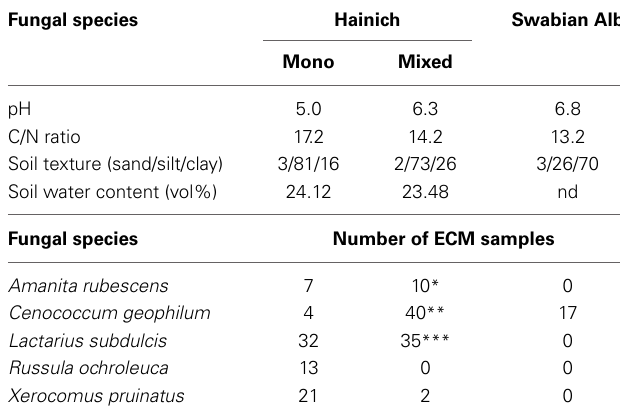
Table 1 | Soil characteristics (0–10cm) and ectomycorrhizal samples collected in the mono-specific beech forest (Mono) and in the mixed (Mixed) deciduous forest stands in the National Park Hainich and in a beech forest in the Swabian